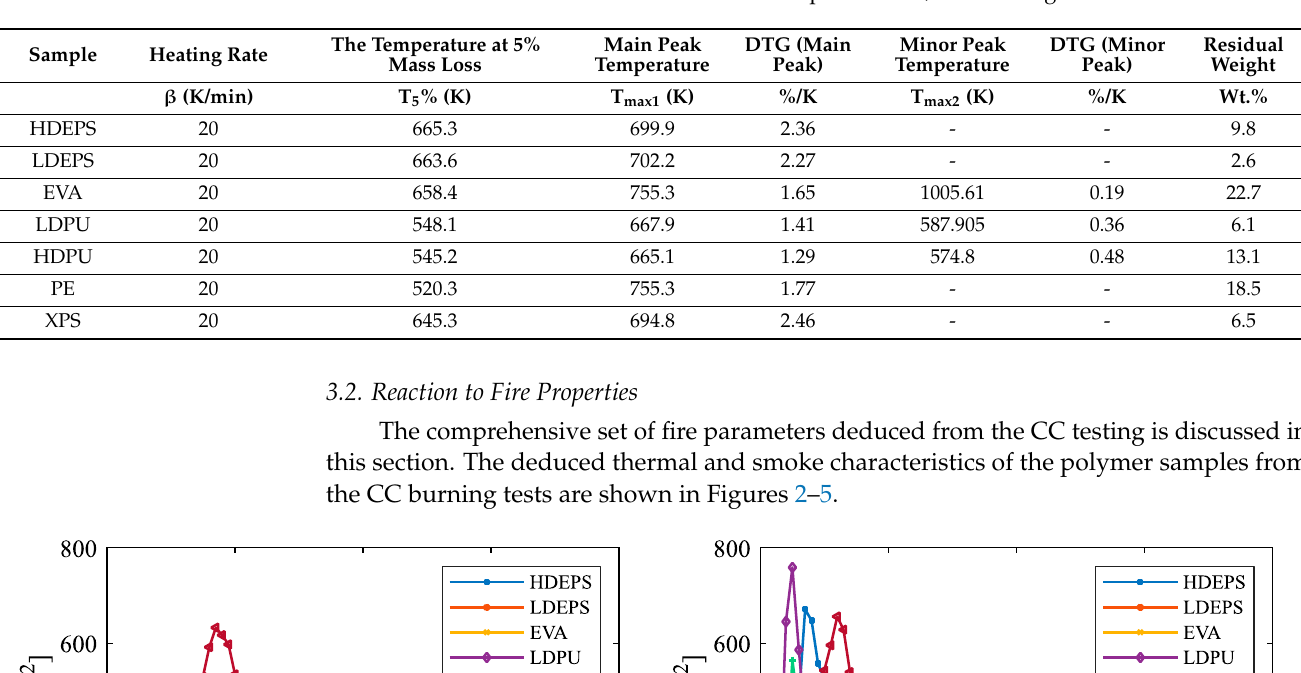
Table 3. Summarised TGA results of the test samples at 20 K/min heating rate.